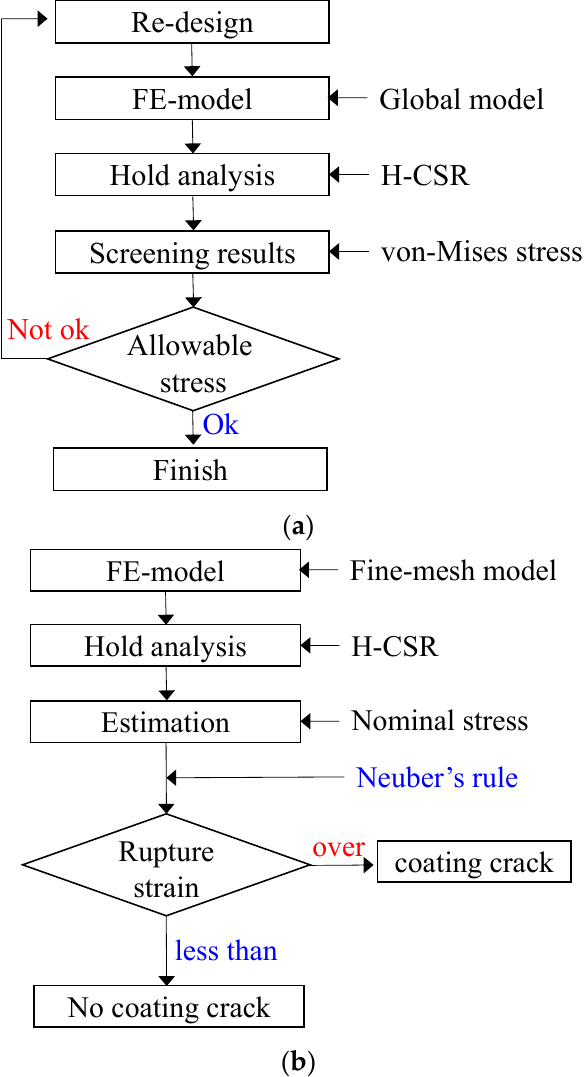
Figure 4. FE analysis procedure (global strength and coating strain). ( a ) global strength estimation. ( b ) coating strain estimation.